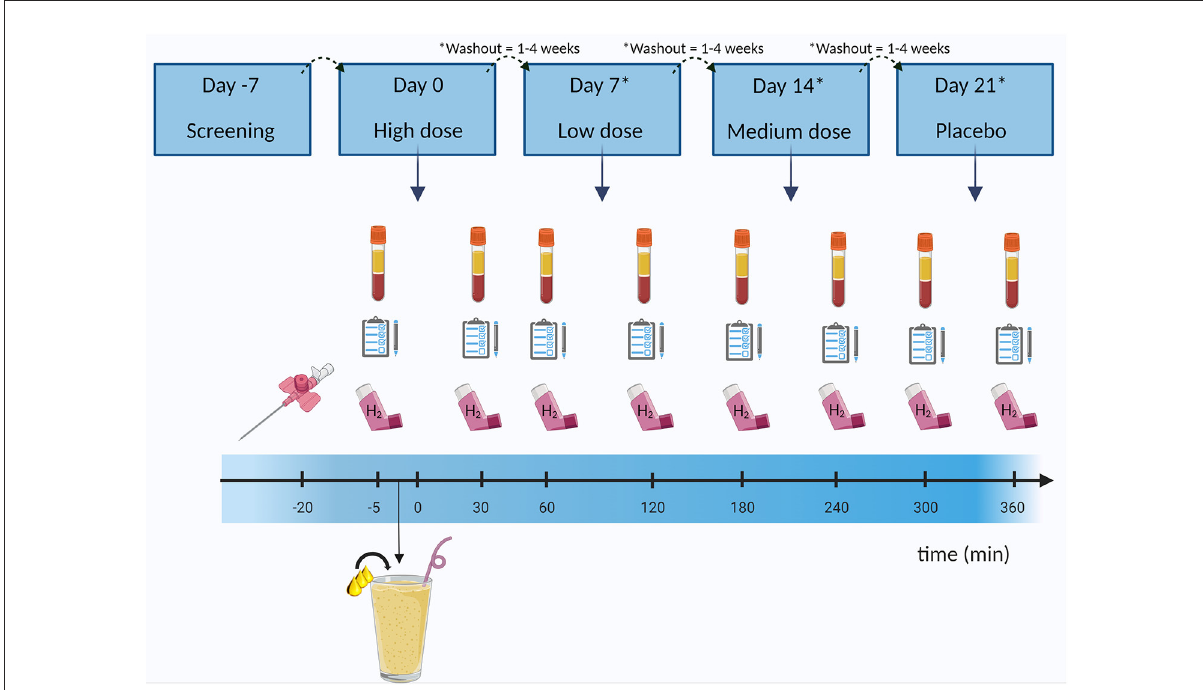
FIGURE1 Example of study design and clinical investigation day. After participants were considered eligible for the study, they came in for four clinical investigation days in which they received a liquid high fat mixed meal (milkshake) containing either the placebo (sunflower oil), or a low, medium, or high dose of butyrate and hexanoate-enriched triglycerides (order in which the doses were received was randomized). Blood was sampled at baseline and after ingestion for 6h. Additionally, hydrogen in breath was assessed by a gastrolyzer and questionnaires were taken to assess gastrointestinal complaints and subjective appetite. Between each clinical investigation days there was a minimum of 1 week (and a maximum of 4 weeks) washout period. H 2 , hydrogen. Created with